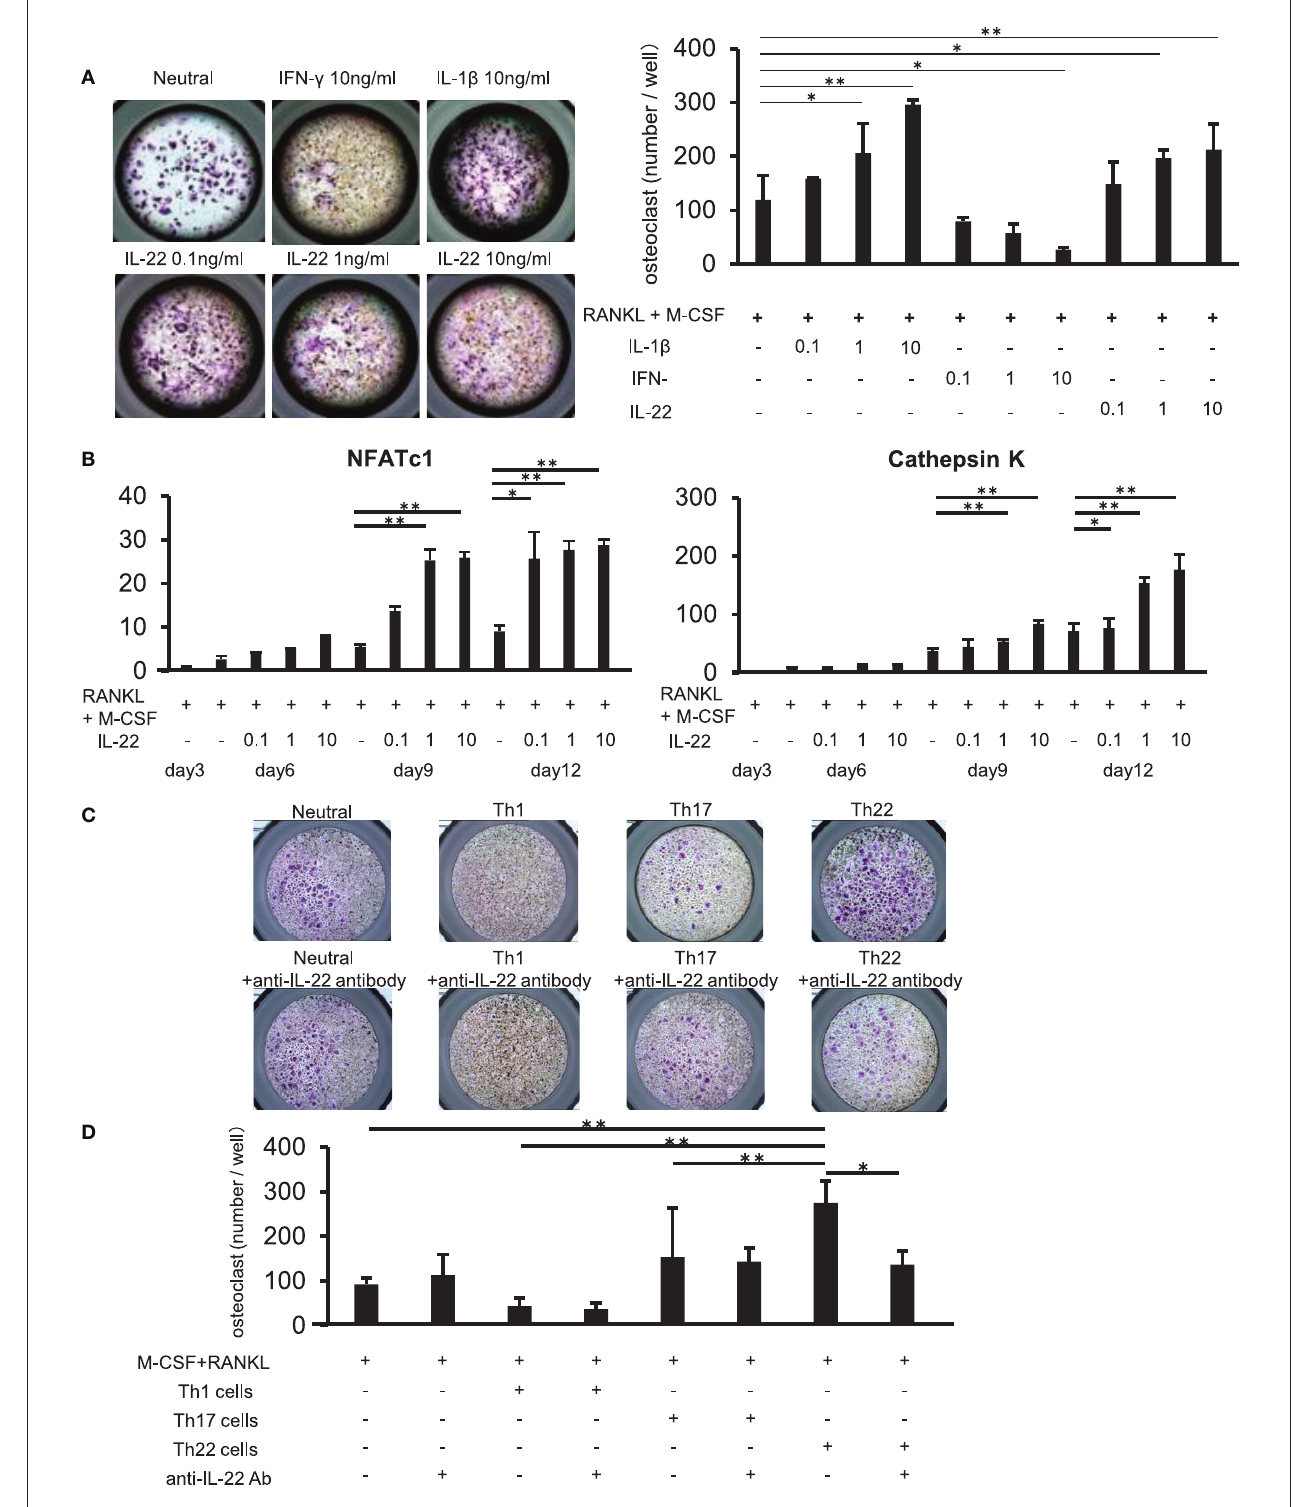
FIGURE 6 | Th22 cells induce osteoclast differentiation through IL-22 production. (A) Osteoclast differentiation from human monocytes following stimulation with M-CSF and RANKL in the absence (Neutral) or presence of IFN- γ (0.1, 1, or 10ng/mL), IL-17 (0.1, 1, or 10ng/mL), or IL-22 (0.1, 1, or 10ng/mL). TRAP-positive, multi-nucleated cells were identified using leukocyte acid-phosphatase staining; representative image of five independent experiments (left; magnification: 200 × ).